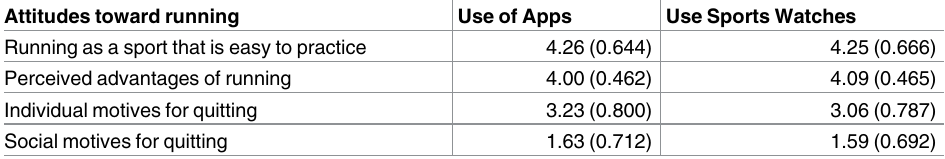
Table 4. Overview of mean scores (and standard deviation) for event runners’ usage of apps and sports watches for the psychographic variables. Attitudes toward